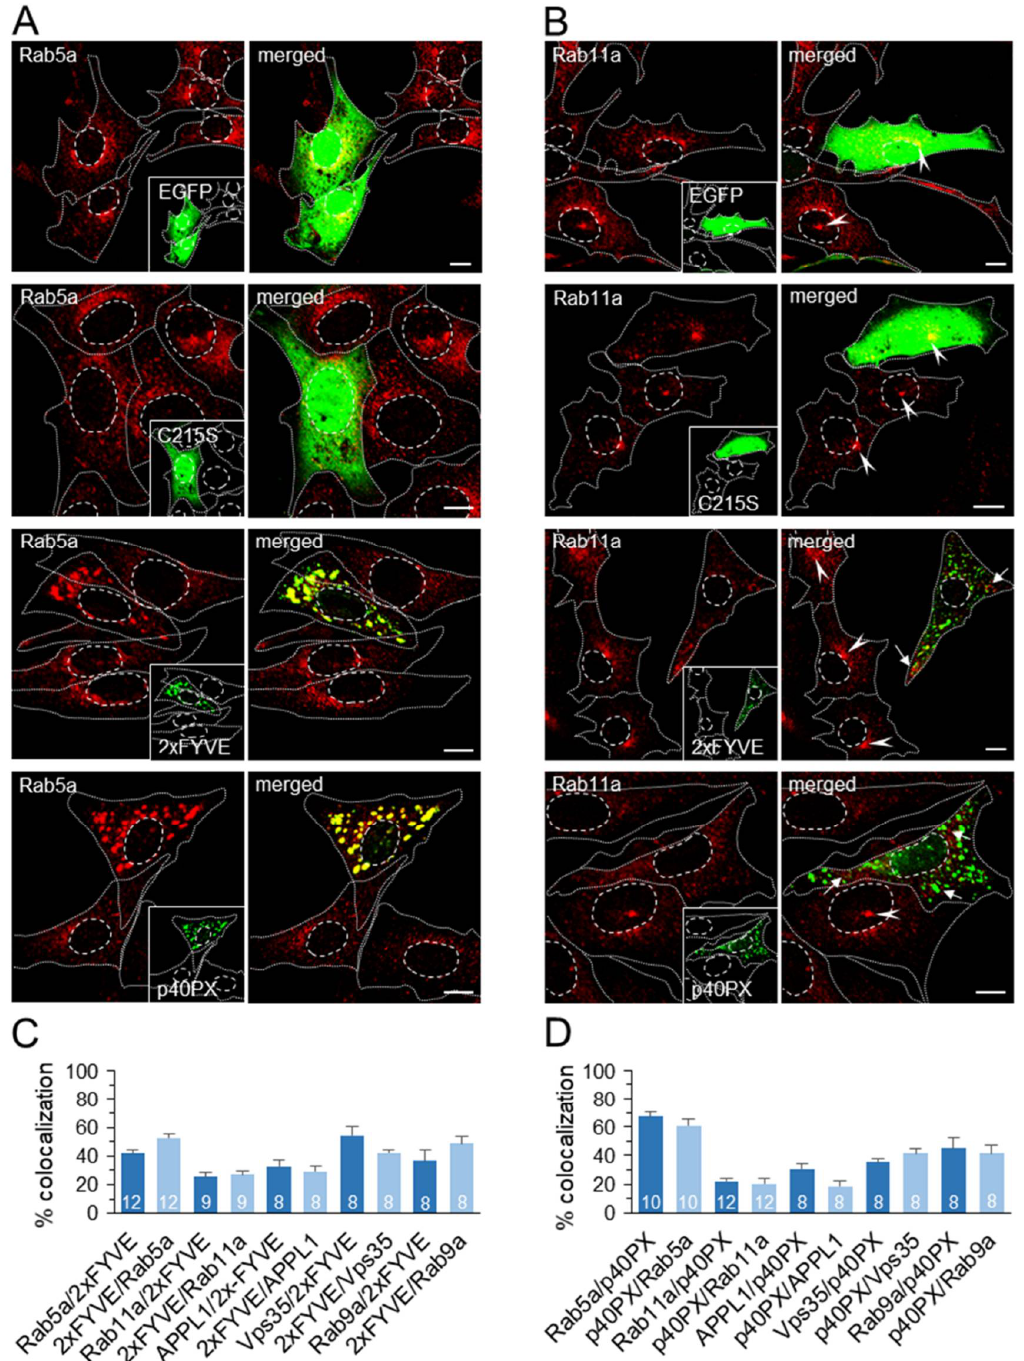
Figure 9. Colocalization of EGFP-2xFYVE and YFP-PX with Rab5a and Rab11a. ( A , B ) Balb 3T3 cells were transfected with either EGFP-MSCV, EGFP-2xFYVE C215S -MSCV (C215S), EGFP-2xFYVE-MSCV, or YFP-p40PX-MSCV for 48 h. Fixed and permeabilized cells were stained with rabbit Abs against Rab5a ( A ) and Rab11a ( B ) and secondary anti-rabbit AF 594 . Arrows point to peripheral Rab11a endosomes in 2xFYVE and p40PX expressing cells, and arrowheads point to the juxtanuclear and subnuclear ERCs. Cell borders are indicated by fine dotted lines and nuclei by fine dashed lines. Bars, 10 μm. ( C , D ) The 3D colocalization of Rab5a, Rab11a, APPL1, Vps35, and Rab9a with EGFP-2xFYVE ( C ) and YFP-p40PX ( D ) based on the M1/M2 coefficients of pixel overlap measured across the Costes-algorithm thresholded z-stacks of confocal images. Data are means ± SEM per cell (number of cells indicated in bars).